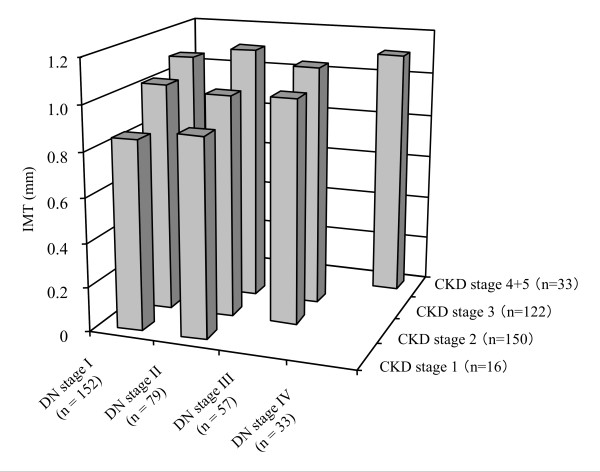
The IMT of the subgroups divided by the stages of CKD and diabetic nephropathy. The IMT increased with the stage progression of CKD in each stage of diabetic nephropathy (P = 0.03 in DN stage I and P = 0.01 in DN stage II).